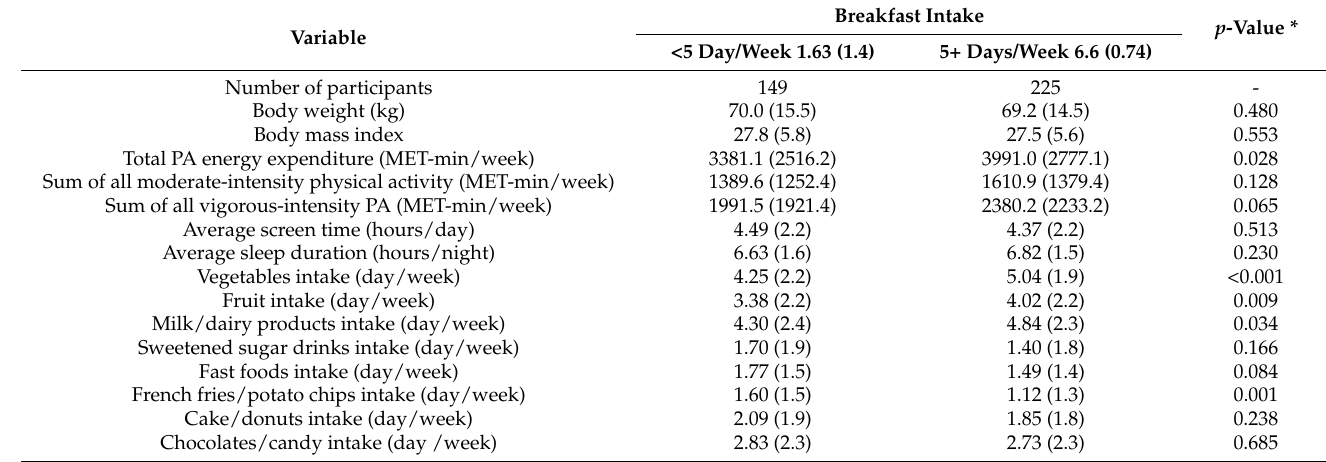
Table 5. Multivariable analysis (MANCOVA) of selected lifestyle variables relative to breakfast intake frequency (less than five days per week versus five or more days per week) while controlling for age and socio-demographic